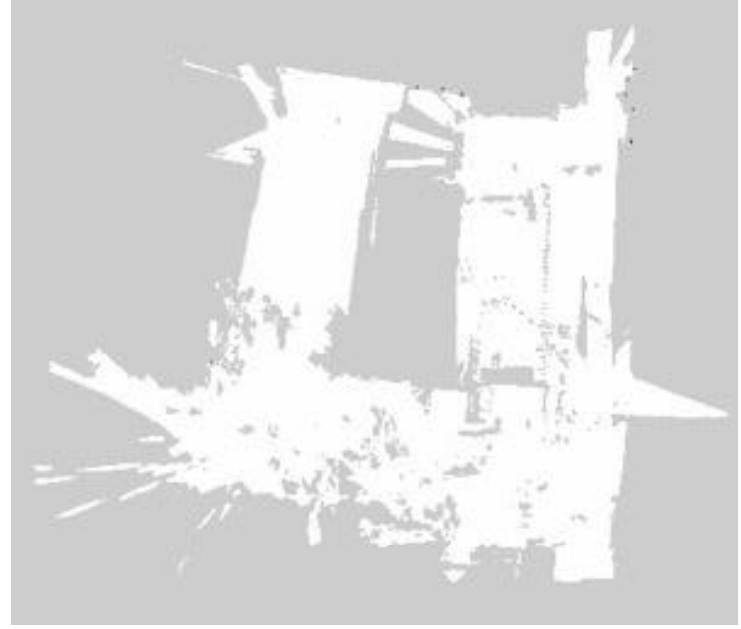
Figure 22. The map using Cartographer (Hokuyo laser rangefinder).